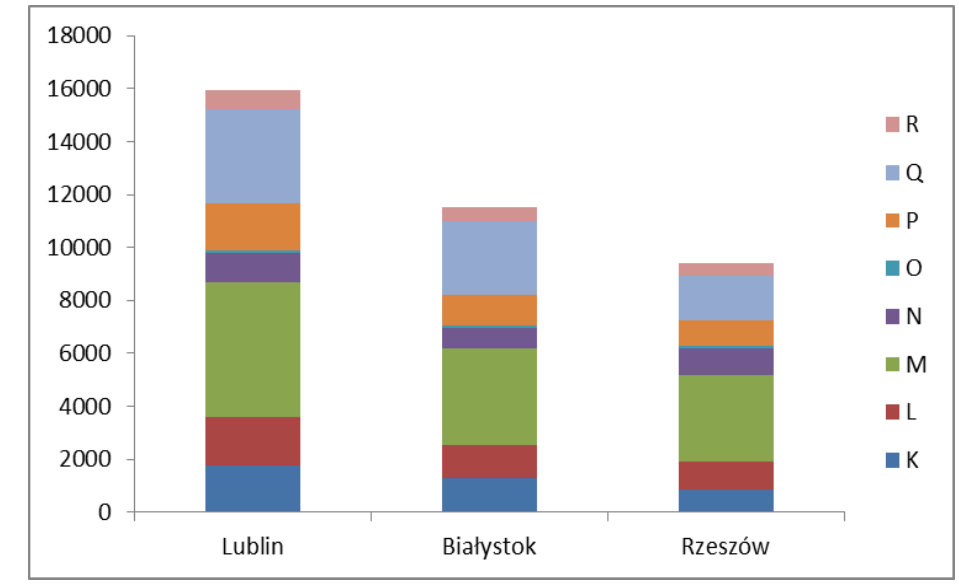
Fig. 8. Services of a higher level in the Białystok, Lublin, and Rzeszów (2014)